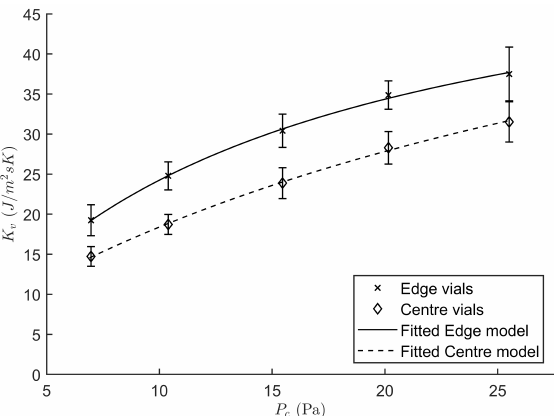
Figure 2. Heat transfer coefficient K v regressed against the chamber pressure P c for both the edge (cross) and centre vial (diamond) population.